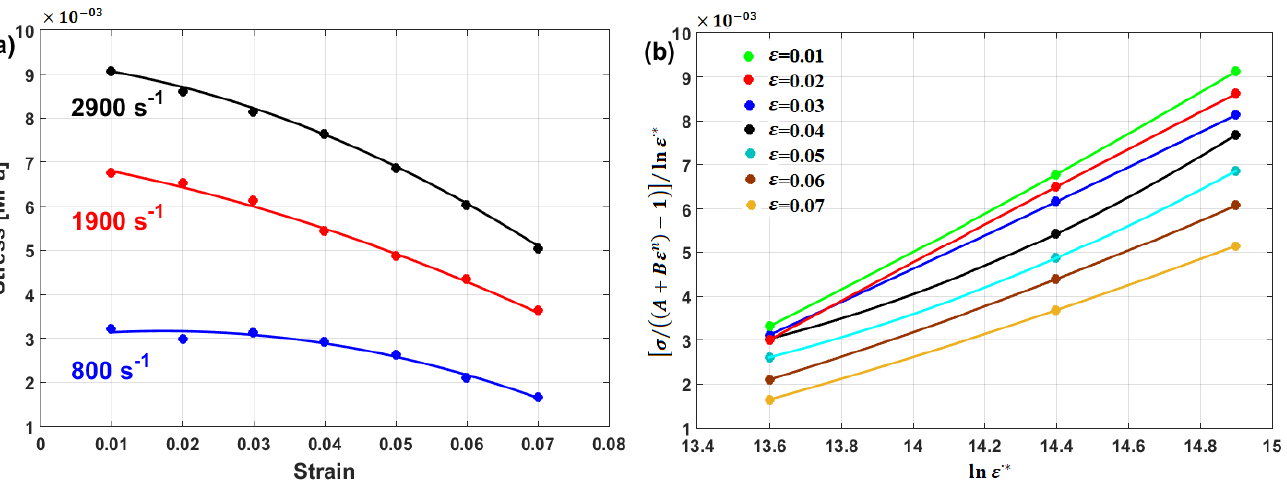
Figure 30. Experimental stresses (markers) compared to predicted stresses (solid lines) for 7050- T7451 aluminum alloy using ( a ) the original JC and ( b ) the modified JC model that was presented by Tan et al. [53]. 3.2.16. Chen JC-Based Modification Chen et al. [82] modified the original JC model to predict the flow behavior of 7050- T745 aluminum alloy at high strain rates and different temperatures. The coupling effect of strain, strain rate, and temperature is taken into account in this modification. The modified JC model that was introduced by Chen et al. [82] can be expressed as